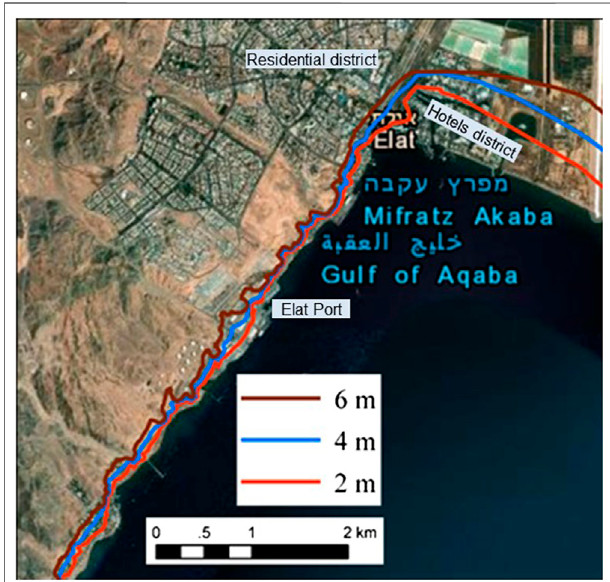
FIGURE 9 | Proposed evacuation zone along the Israeli HGEA coast. The blue line delimits the evacuation zone constructed according to the AttenuationModel(MCDEM,2016),onthebasisof4-mwaveheightalongthe coast. For comparison, the red and brown lines delineate evacuation zones for wave heights of 2 and 6 m along the coast, respectively. See Evacuation Zone for detailed explanation. Background map from Google